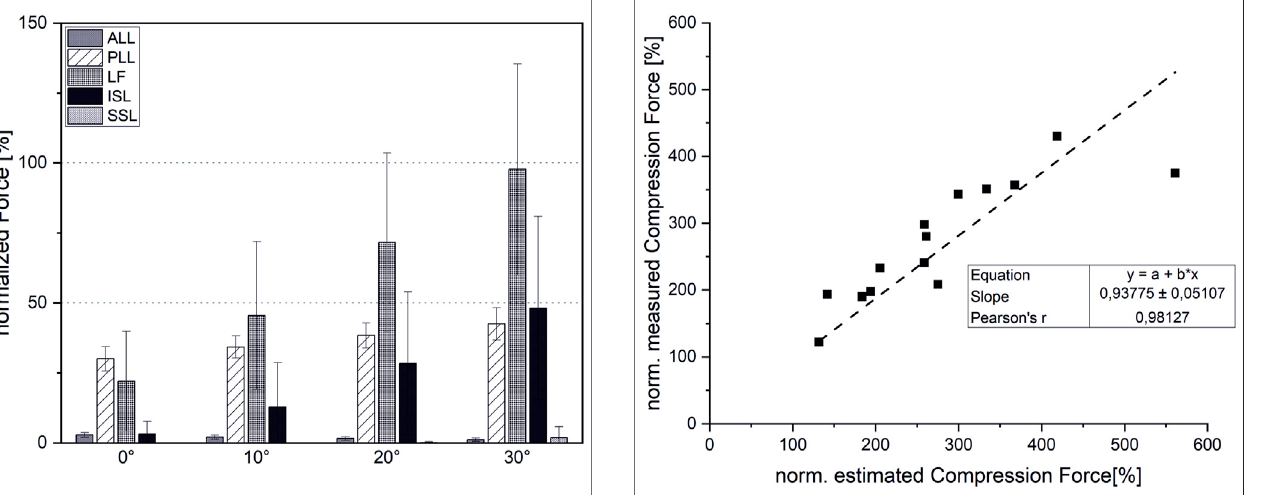
FIGURE 7 | Ligament forces normalized to maximal force at the end of the linear region before failure.